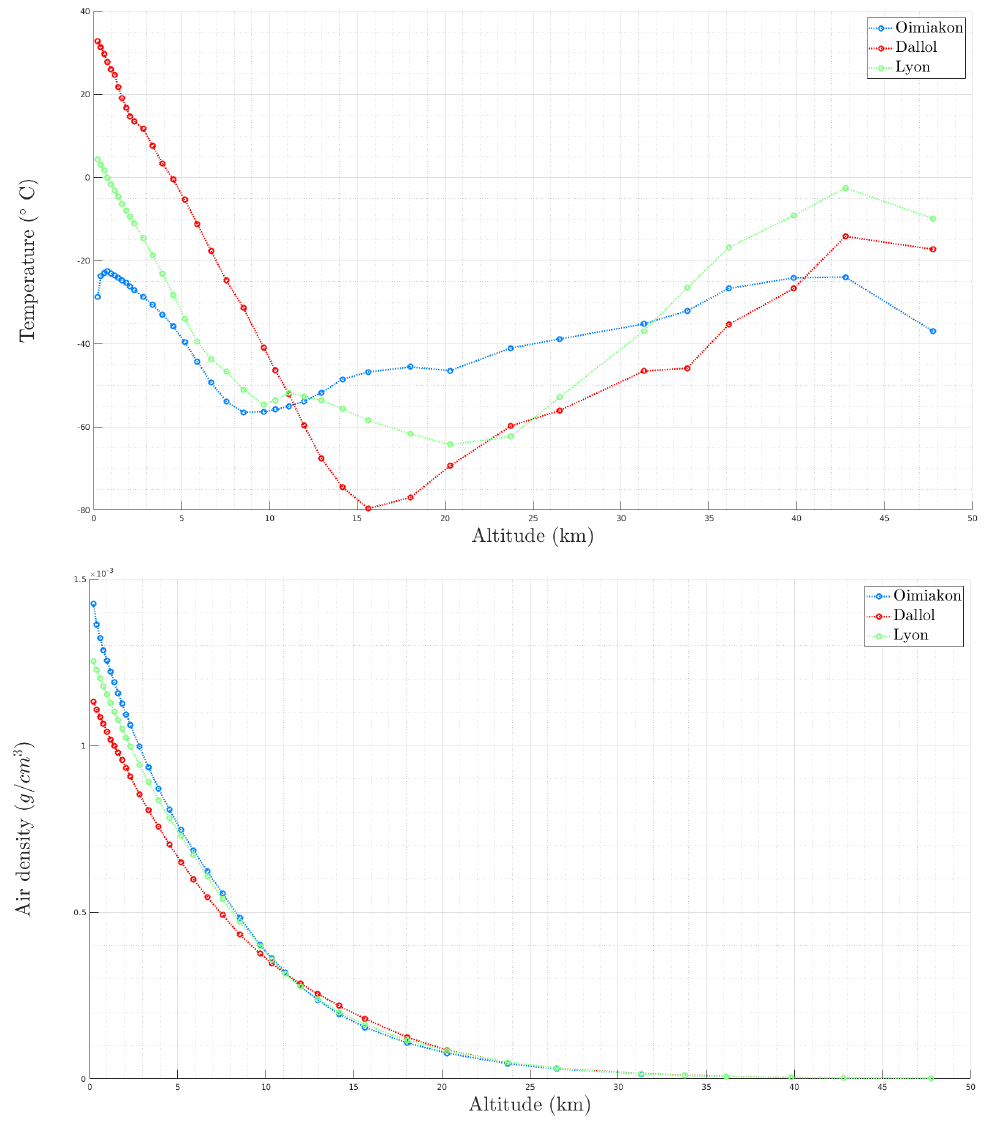
Figure 10. ( Top ) Temperature and ( Bottom ) density profiles for altitudes from 0 to 50 km of extreme atmospheres: Oimiakon (in blue) and Dallol (in red) and a moderate one, Lyon (in